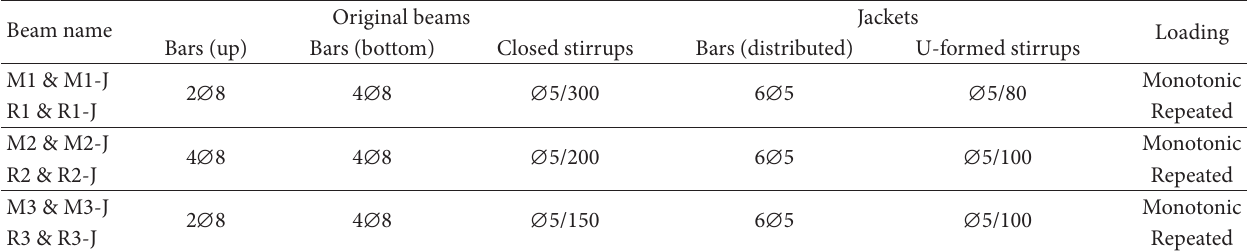
T 1: Steel reinforcement and loading type of the tested